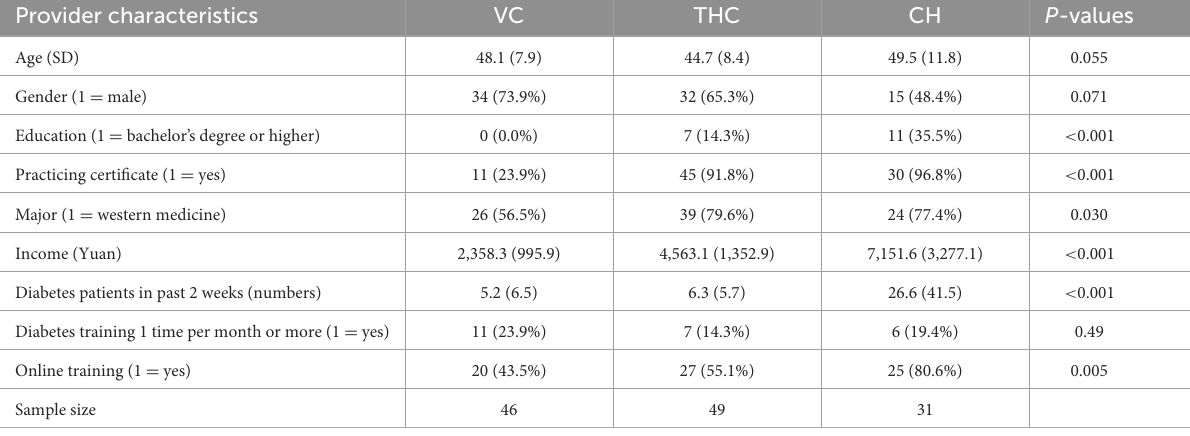
TABLE 1 Providers characteristics across three tiers of China’s rural healthcare system. Provider characteristics